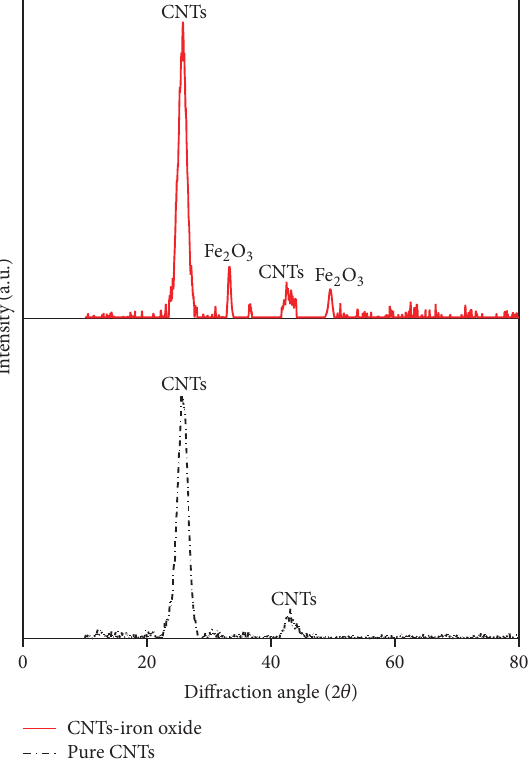
Figure 5: XRD analysis of pure CNTs and iron oxide impregnated CNTs.